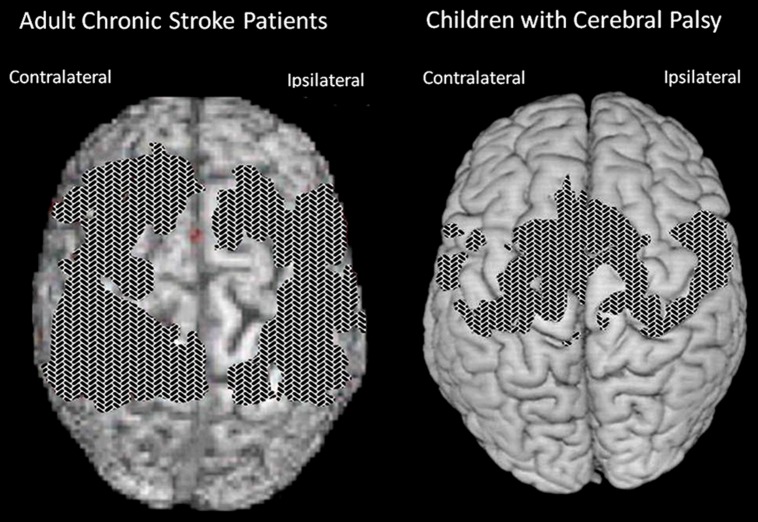
Cortical surface-rendered image of gray matter pre- to post-treatment change after CI therapy in (A) adults with chronic stroke and (B) children with hemiparetic cerebral palsy. Gray matter increases displayed on a standard brain. Surface rendering was performed with a depth of 20 mm. Cross-hatched areas indicate t statistics ranging from 2.0 to 6.7, corrected for family-wise error. Panel (A) adapted from Gauthier et al. (2008); panel (B) adapted from Sterling et al. (2013).